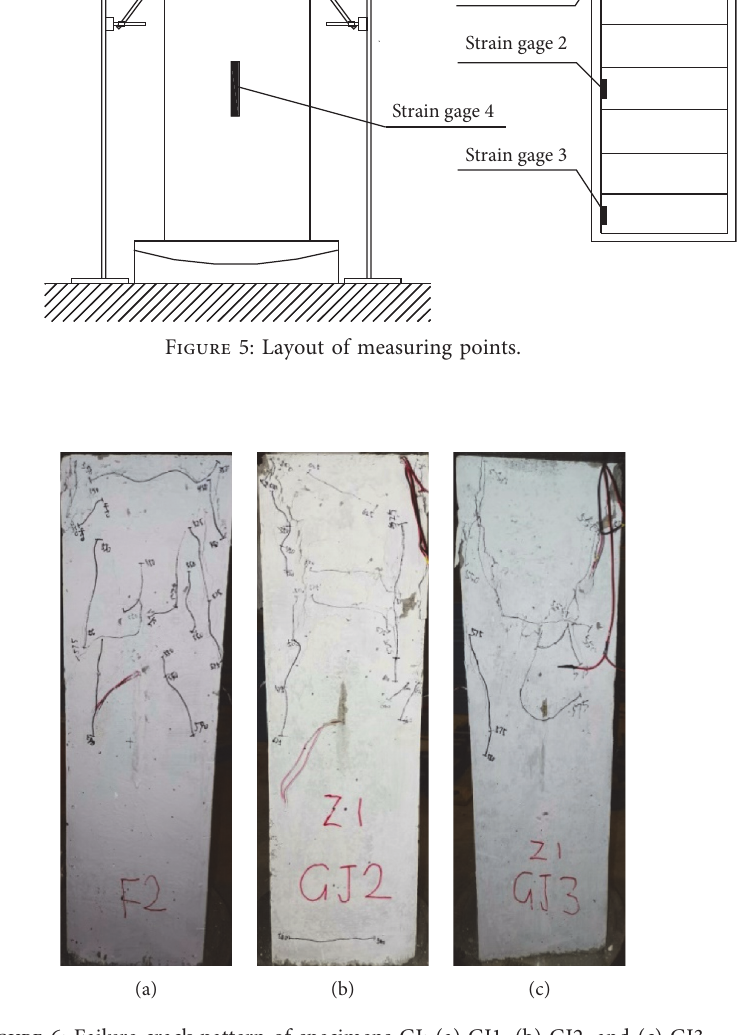
Figure 6: Failure crack pattern of specimens GJ: (a) GJ1, (b) GJ2, and (c)